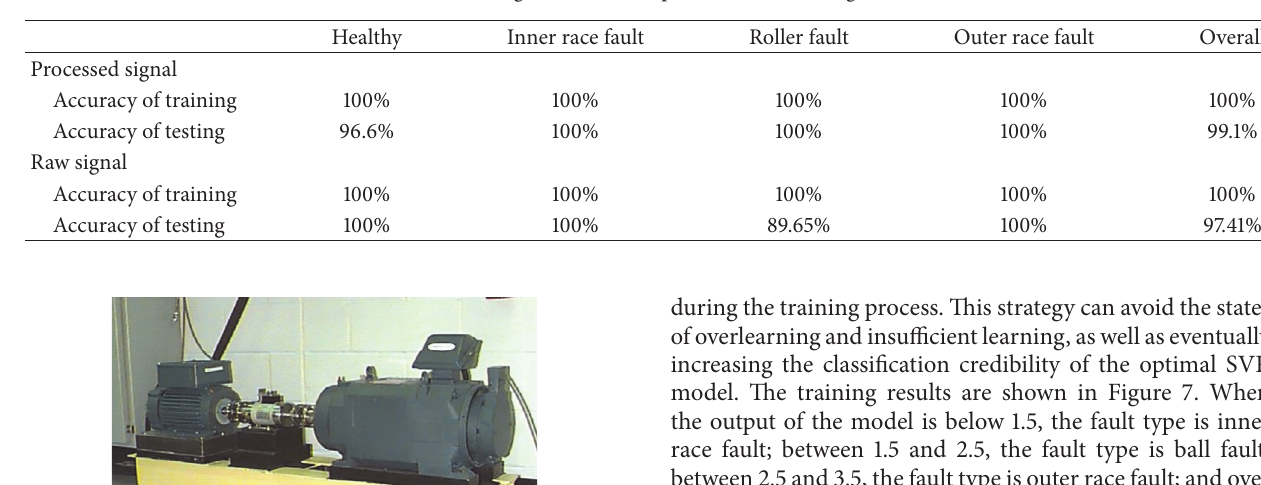
Table 2: Diagnosis results of processed and raw signals.